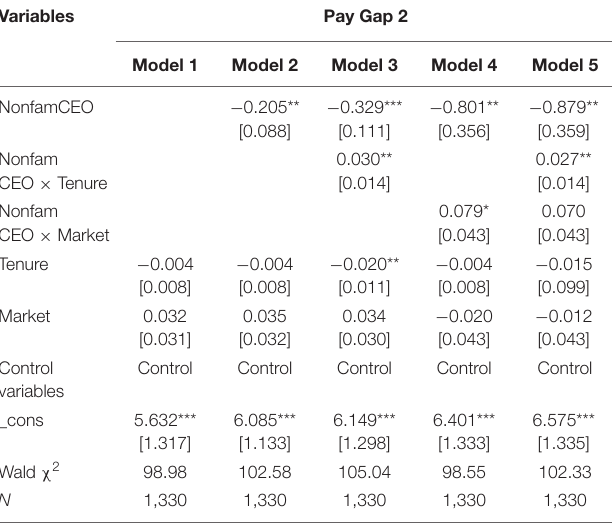
TABLE 6 | Robustness test: Substitute dependent